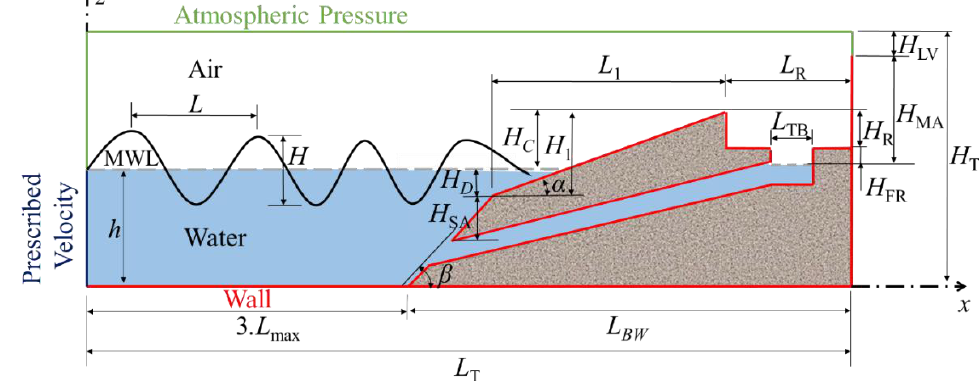
Figure 2. Illustration of the 2D computational domain for the one ramp OTD-WEC.